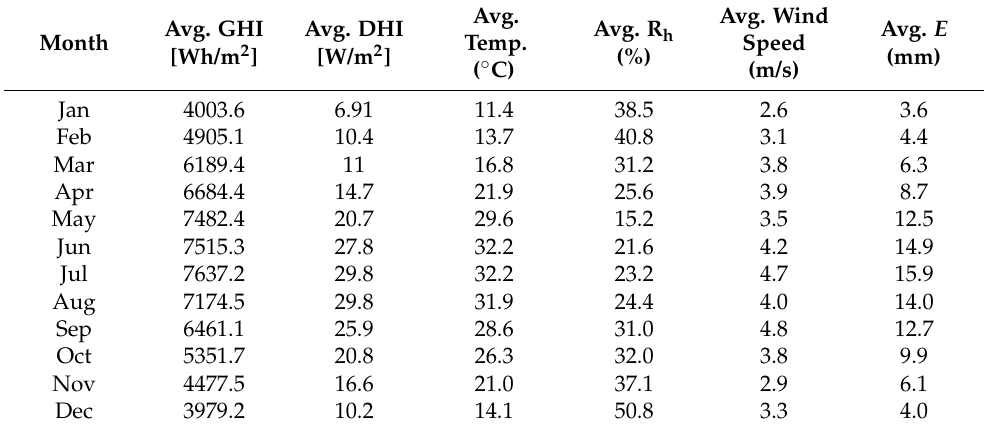
Table 1. Monthly statistics of the meteorological variables near the study